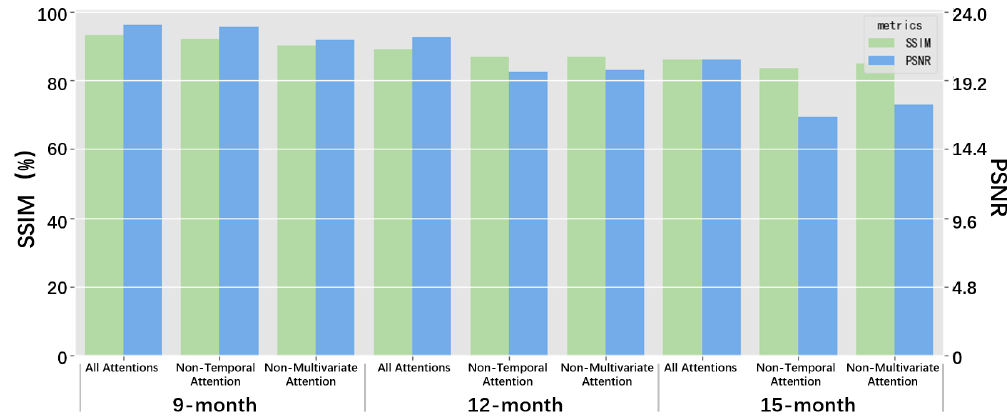
Figure 13. The performances of the ENSO-ASC when removing one of the attention weights.